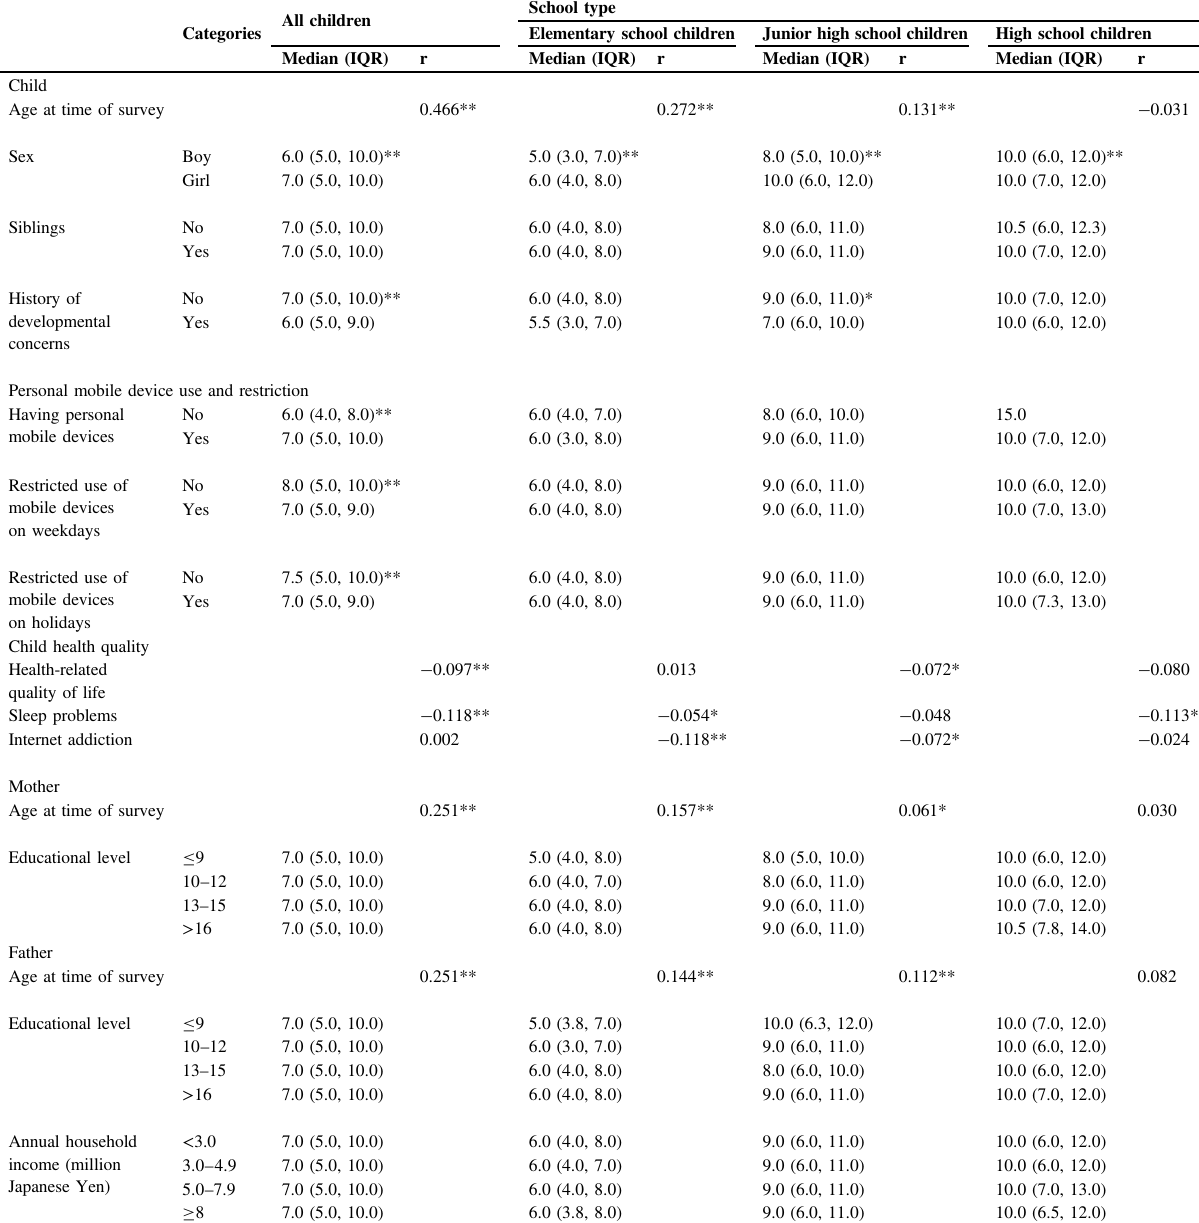
Table 4 Associations between child ’ s age at fi rst use of a mobile device and characteristics of participants. All Categories